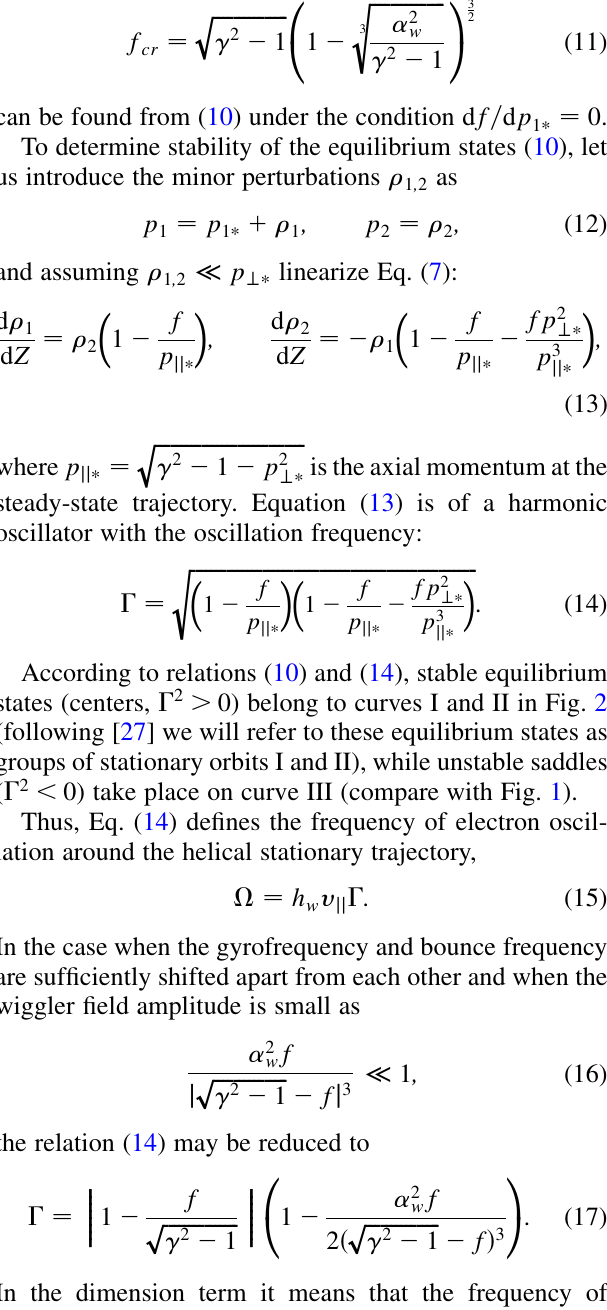
ffiffiffiffiffiffiffiffiffiffiffiffiffiffiffi